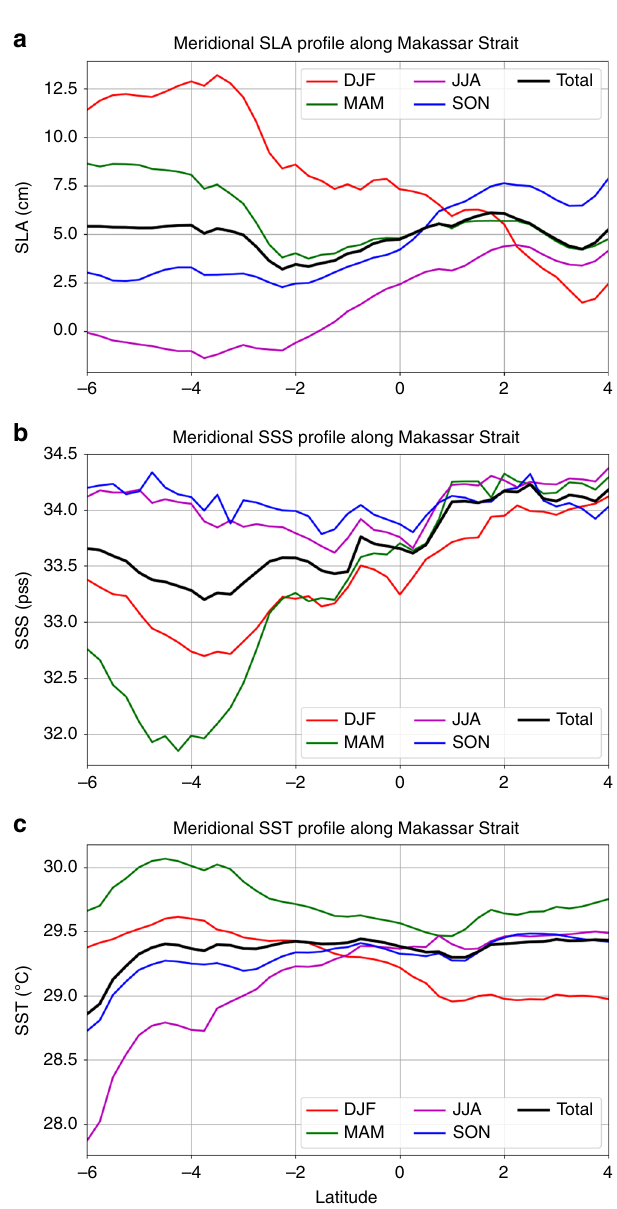
Fig. 10 Meridional pro fi les of sea level anomalies, sea surface salinity, and sea surface temperature along the Makassar Strait. a Sea level anomalies. b Sea surface salinity. c Sea surface temperature. The data shown correspond to the zonally averaged across the box shown in Fig.